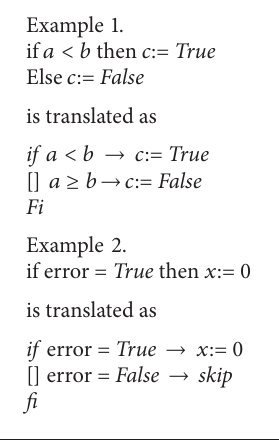
Algorithm 1: Two examples of guarded command